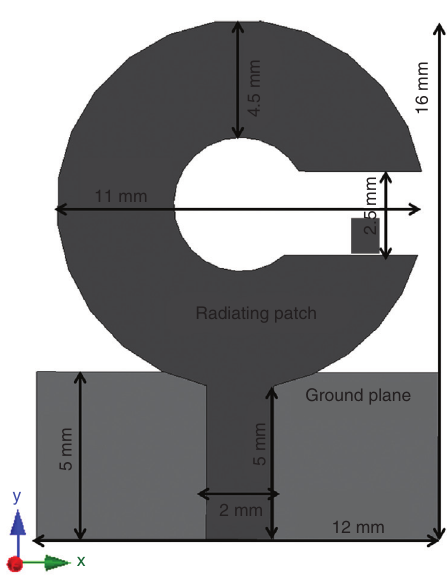
Figure 2 Design layout of the proposed antenna.